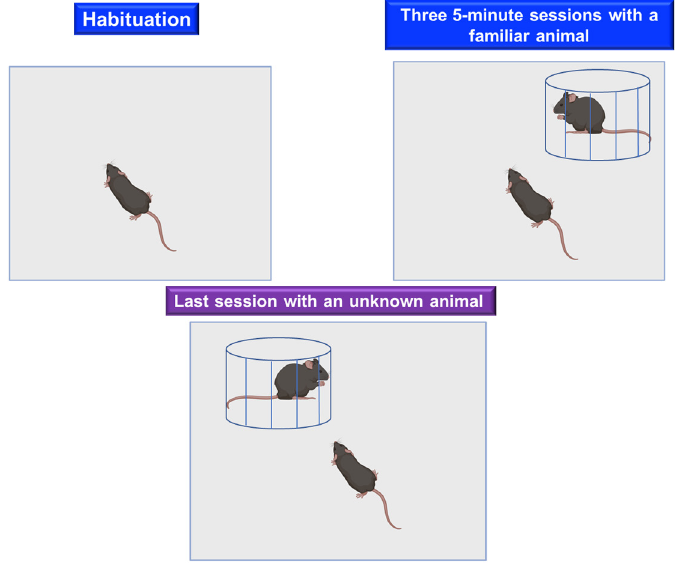
Figure 6. Social recognition test. Repeated exposure of the animal to a familiar individual precedes a final confrontation with an unknown individual, at which time the degree of interaction with the previous one is compared to the degree of interaction with respect to the previous one.